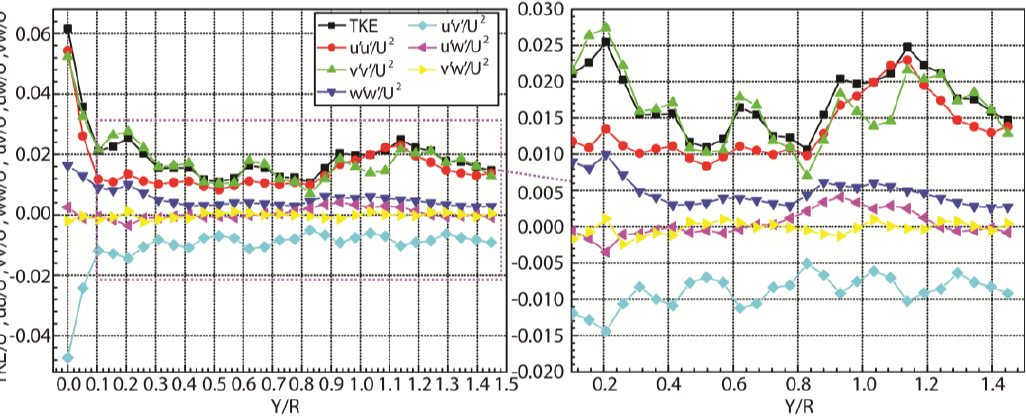
Figure 11. Turbulence statistics profiles at Z / R = 0.00 under the ballast condition: Left . The global distribution of the turbulence statistics profiles; Right . Close up of the turbulence statistics profiles).